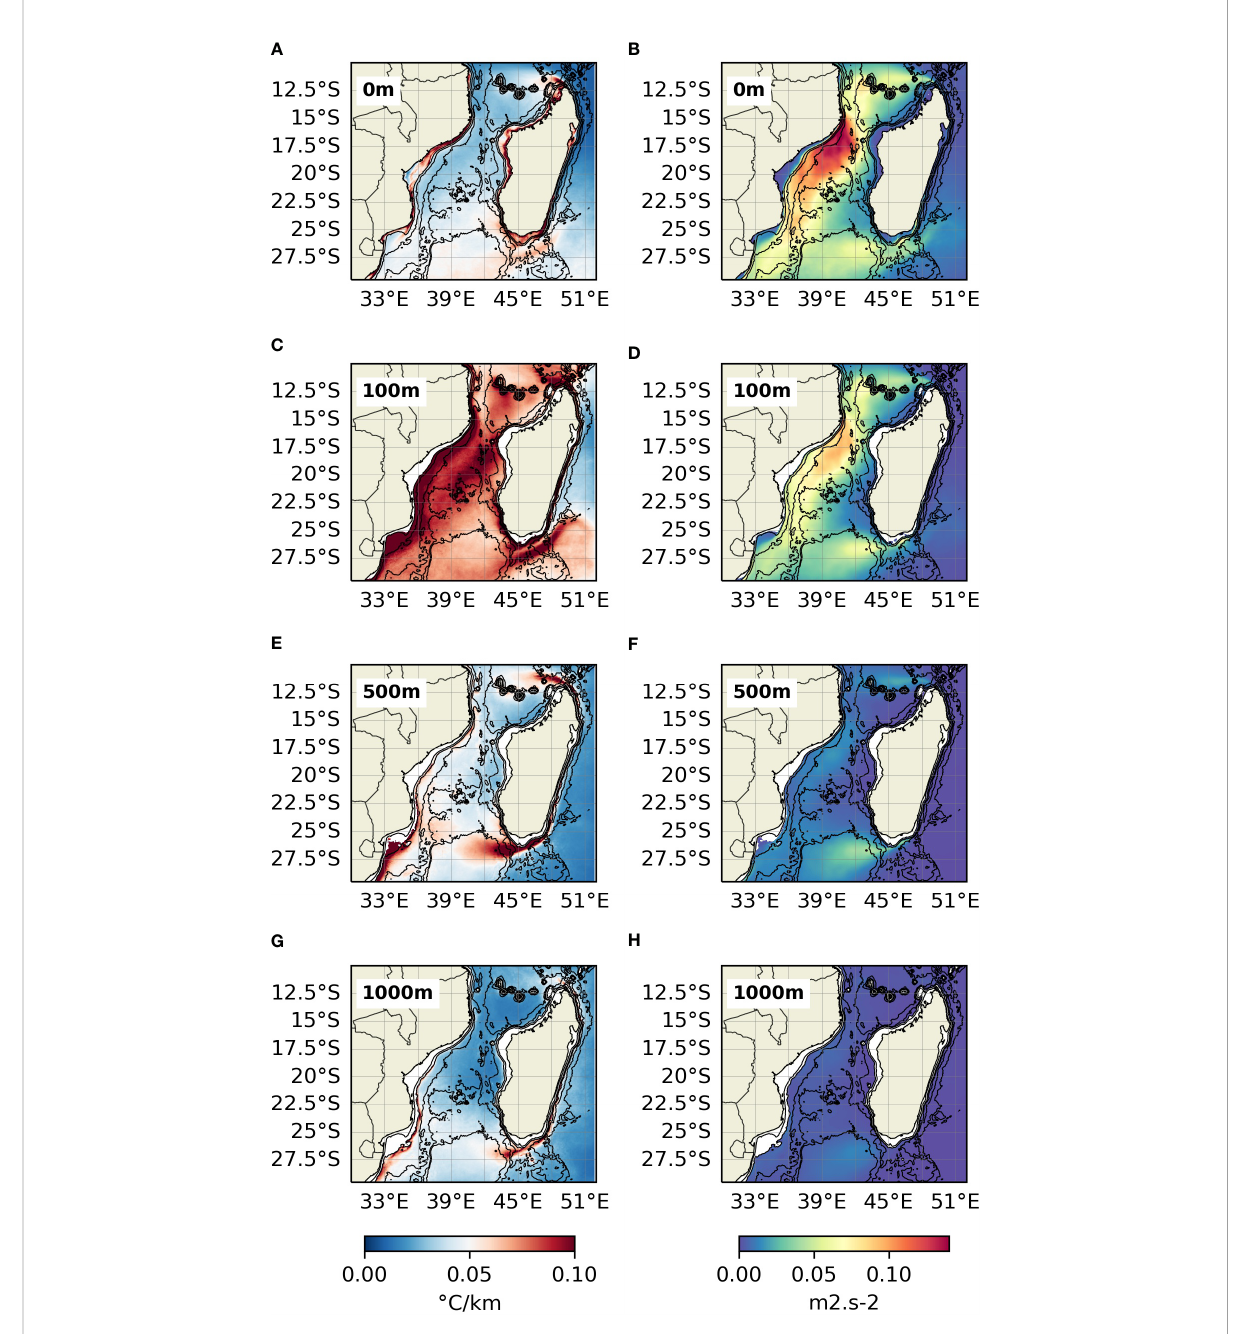
FIGURE 4 Mean temperature front intensity (A, C, E, G) and EKE (B, D, F, H) from MOZ36 at the surface (A, B) , -100 m (C, D) , -500 m (E, F) and -1000 m (G, H)